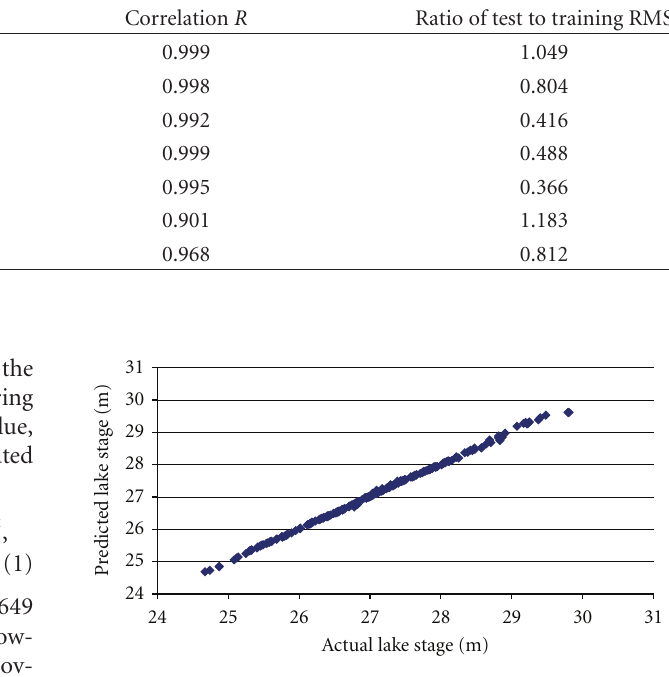
Figure 4: ANN-predicted versus actual lake